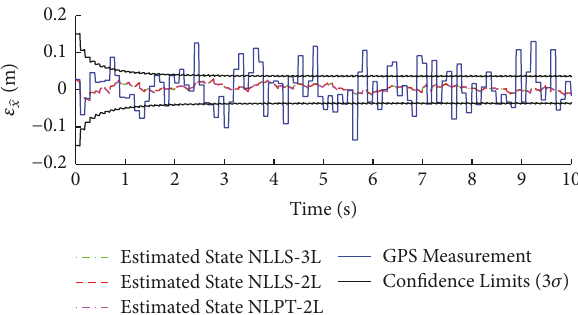
Figure 4: e 𝑥(𝑖|𝑘) in function of time for NLLS-3L, NLLS-2L, and NLPT-2L